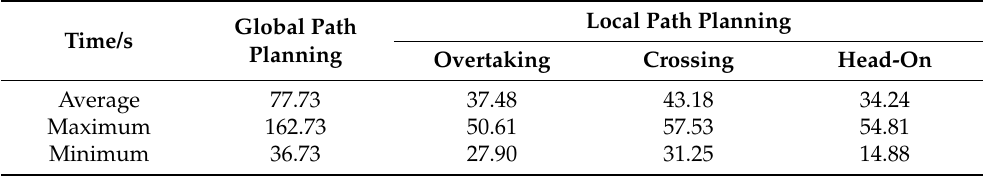
Table 3. The running time of global and local path planning.